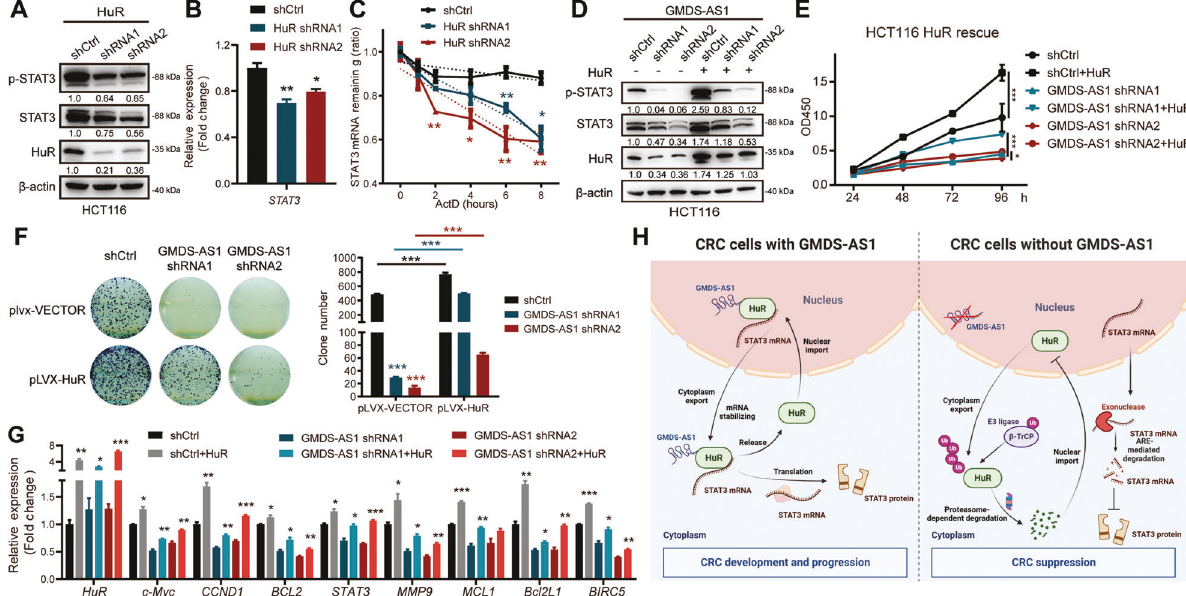
Fig. 7 HuR functionally mediates GMDS-AS1 to maintain stable STAT3 mRNA expression. A The protein levels of HuR, p-STAT3 (Y705) and total STAT3 in HCT116 cells stably transduced with control or HuR shRNA were detected by immunoblotting. β -actin was the endogenous control. B Relative mRNA expression levels of STAT3 in HuR control/KD HCT116 cells were measured by qPCR. C Relative mRNA expression levels of STAT3 in HuR control/KD HCT116 cells after ActD (10 μ M) treatment for the indicated times were measured by qPCR. D The protein expression levels of HuR, p-STAT3 (Y705) and total STAT3 in GMDS-AS1 control/KD HCT116 cells with or without HuR overexpression were detected by immunoblotting. E CCK-8 assays of control and GMDS-AS1-KD HCT116 cells with or without HuR overexpression. F Colony formation assays of control and GMDS-AS1-KD HCT116 cells with or without HuR overexpression. Left, representative images; right, colony number quanti fi cation. G Relative mRNA expression levels of STAT3 target genes in GMDS-AS1 control/KD HCT116 cells with or without HuR overexpression were measured by qPCR. 18S was the endogenous control. B , C , E – G Values are expressed as the means ± SEM, n = 3. *** p < 0.001, ** p < 0.01, and * p < 0.05 by two-tailed Student ’ s t test. H Schematic illustration showing the GMDS-AS1-HuR-STAT3 axis and its regular function in CRC oncogenesis. In the presence of GMDS-AS1, HuR binds to STAT3 mRNA in the nucleus, and this complex is then transported to the cytoplasm. HuR prevents STAT3 mRNA from rapid AU-rich element (ARE)-mediated degradation; this protective effect maintains high STAT3 protein expression levels and promotes CRC progression. When GMDS-AS1 is depleted, more HuR proteins are ubiquitinated by the E3 ligase β -TrCP and eliminated via the proteasome pathway. In this case, the STAT3 protein level is dramatically decreased, and CRC tumorigenesis is blocked (Created with